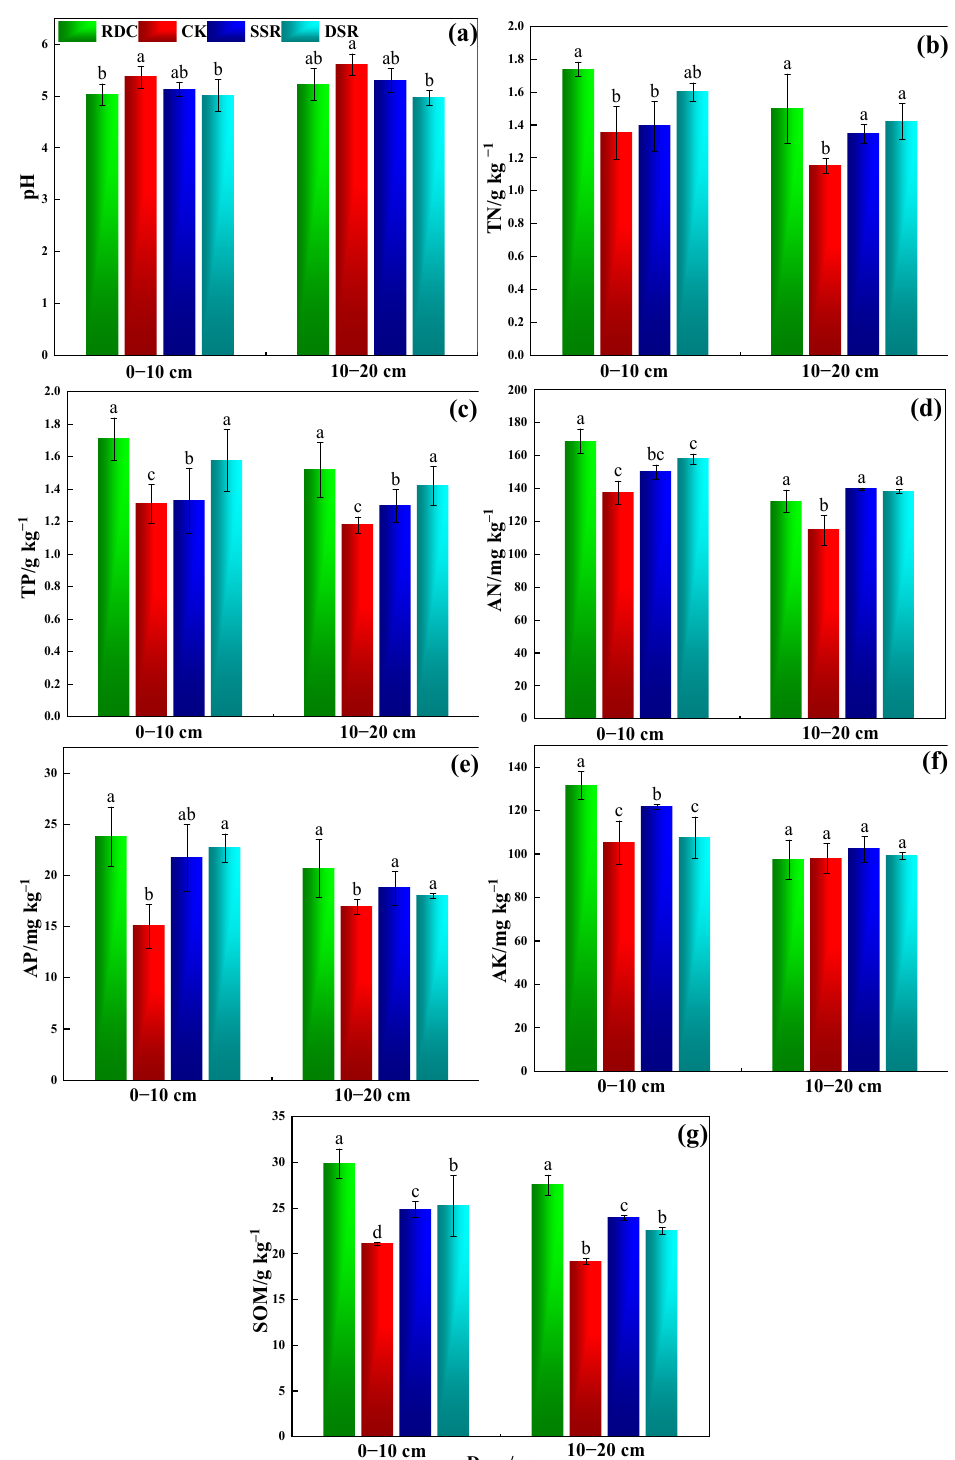
Figure 3. Effects of different planting patterns on the chemical properties of the soil. RDC: rice– duck–crayfish ecological co-culture system, CK: idle field, SSR: single-season rice planting system,